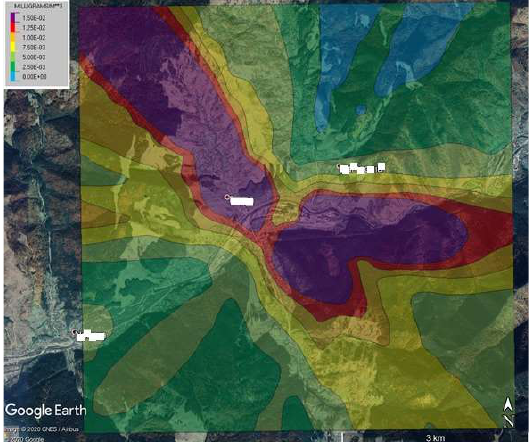
Figure 17. Annual CO concentration in the area of interest — Google Earth Pro .